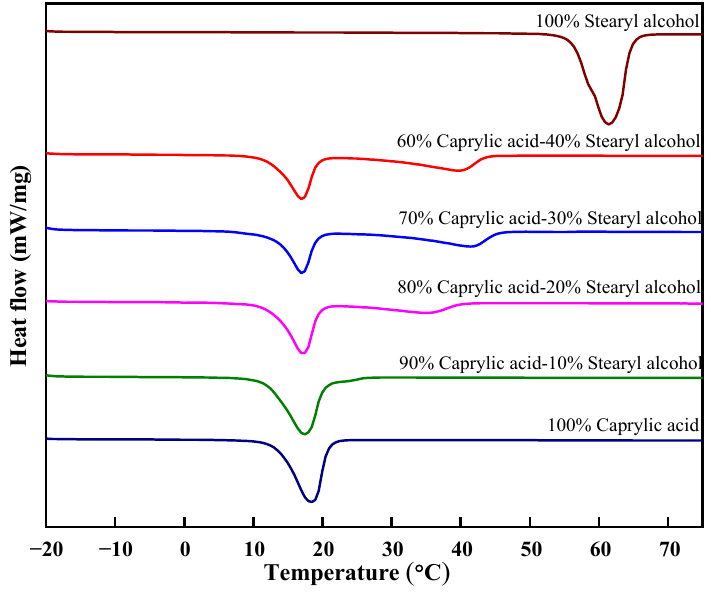
Figure 4. Heating curves of the different mass proportions of a binary mixture. The phase diagram of the eutectic binary mixture was plotted based on the measured onset melting point temperature with the DSC for different mass proportions. The onset melting point temperature of the binary mixture plotted against the mole fraction of the caprylic acid is shown in Figure 5. The solidus temperature remained approximately invariant whereas the liquidus line varied with the incremental mole fractions of the caprylic acid. The second peak diminished slowly with the increase in mass fraction of the caprylic acid; a minimum onset melting point in the curve was marked at 0.9 and 0.1 mole fraction of caprylic acid and stearyl alcohol, respectively. Thus, the minimum onset melting point of 11.4 ◦ C was confirmed as the eutectic point for the caprylic acid-stearyl alcohol binary mixture.